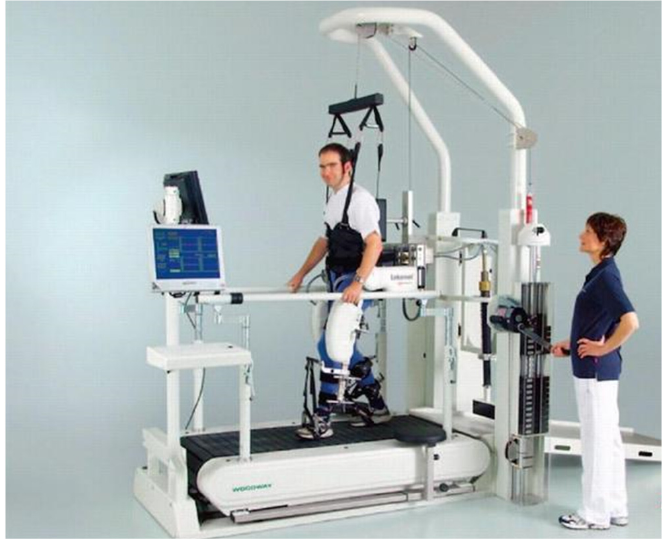
Figure 1. Typical exoskeleton robots: Lokomat.